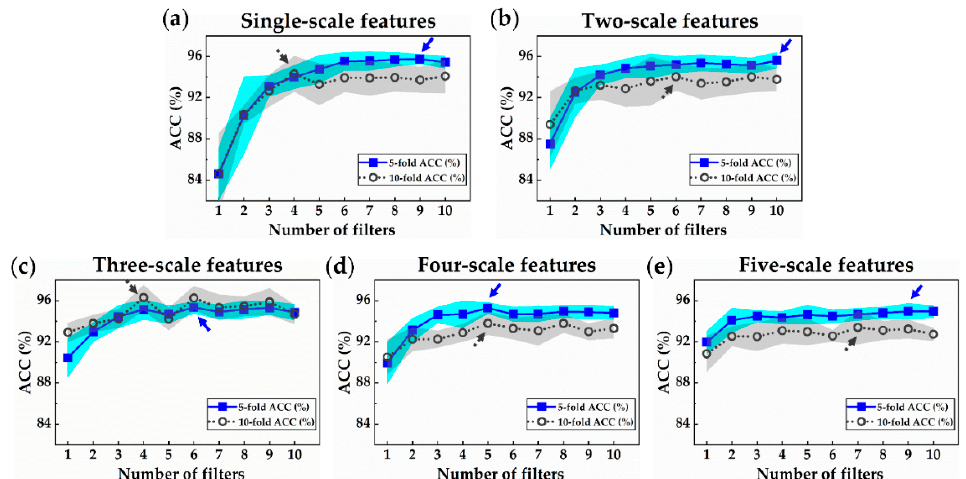
Figure 7. Accuracy trends of the proposed myocardial infarction (MI) detection models plotted in shaded error bar. Blue- and gray-shaded areas indicate the range of one standard deviation, and the best average accuracy under the same scale number is marked by an arrow: Accuracy of models using ( a ) single-scale features; ( b ) two-scale features; ( c ) three-scale features, ( d ) four-scale feature, and ( e ) five-scale features.